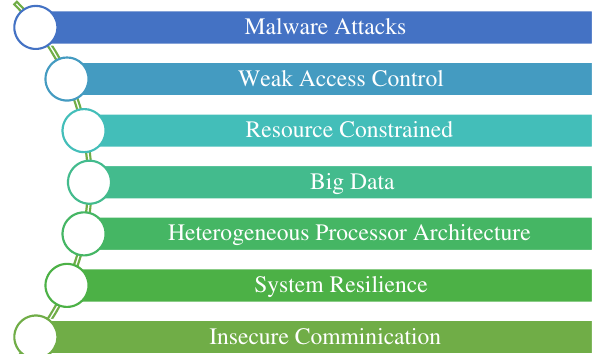
Figure 1. IoT security